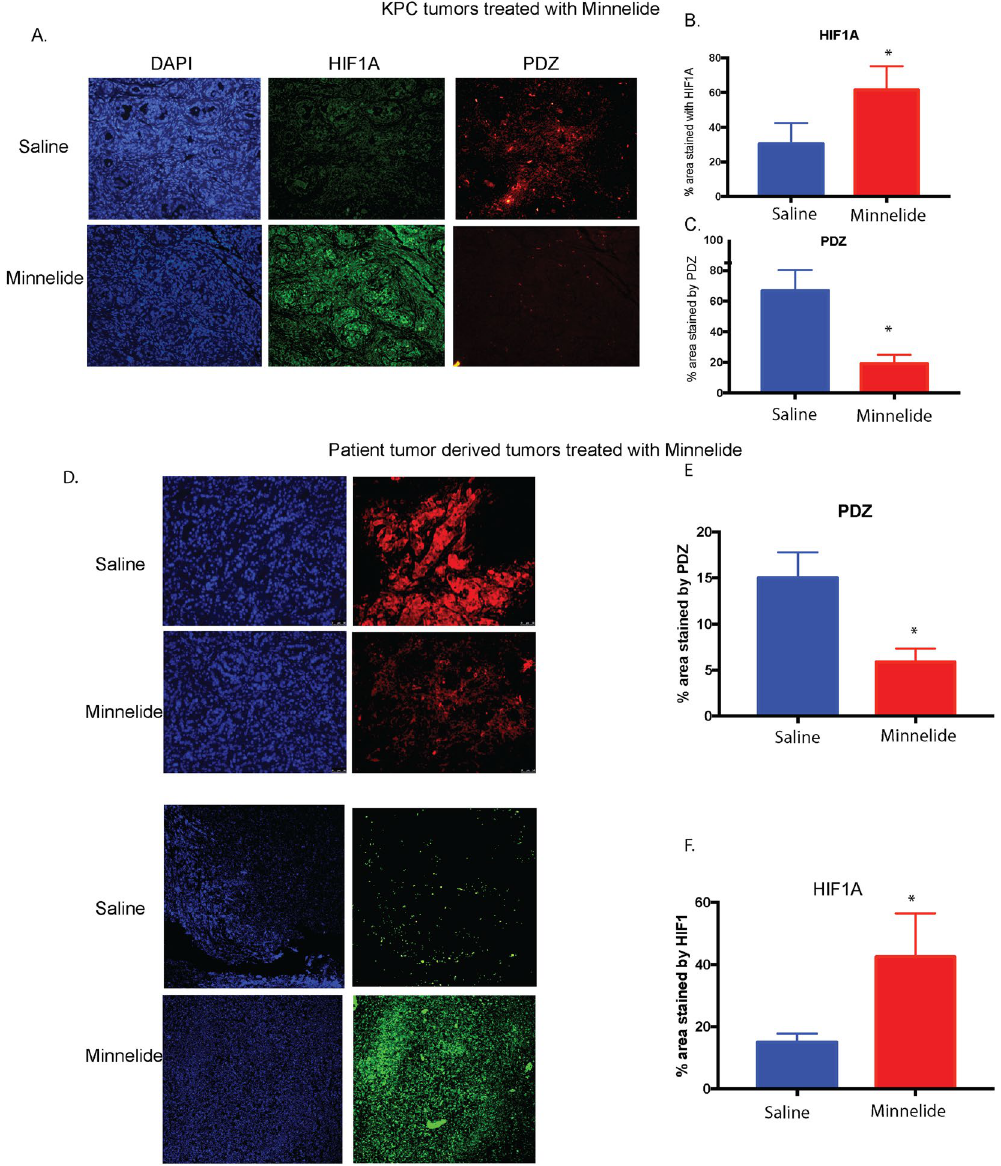
Figure 2. Treatment with triptolide pro-drug Minnelide increases accumulation of HIF1A protein in the tumors while decreasing hypoxia. KPC animals were treated with 0.42 mg/kg Minnelide and the tumors at the end of the treatment were stained for pimonidazole (PDZ) and HIF1A. representative images are shown ( A ), image from 5 animals is quantitated for HIF1A ( B ) along with PDZ ( C ). Similarly, patient tumor derived xenografts were treated with Minnelide 0.4 mg/kg for 20 days and the tumors were stained for PDZ and HIF1A. Representative tumor images are shown ( D ), image from 5 animals is quantitated for HIF1A ( B ) along with PDZ ( C